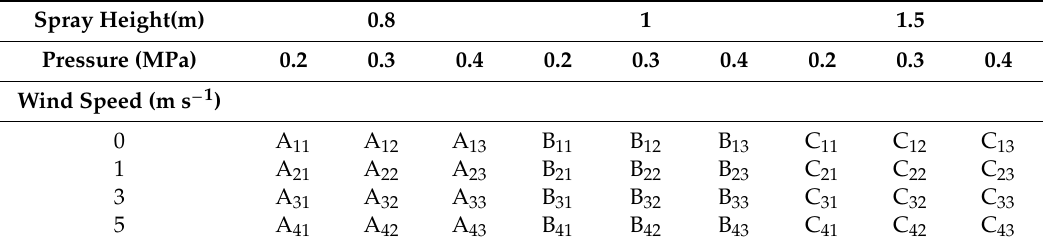
Figure 3. Droplets deposition in target area at different wind speed (0 m s − 1 and 3 m s − 1 ). ( a ) The distribution of droplets is ideal at 0 m s − 1 , ( b ) The droplet was influenced by wind clearly and the distribution of droplets is not satisfied at 3 m s − 1 . Table 2. Total variates of spray height (0.8, 1, and 1.5 m), pressure (0.2, 0.3, and 0.4 MPa) and wind speed (0, 1, 3, and 5 m s − 1 ).